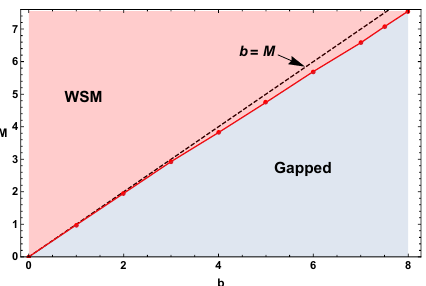
Figure 6. Phase diagram in ( b; M ) space. We used T = 2 =(cid:25) . Unlike the (cid:12)eld theory, M c =b = 1 holds only approximately. Dashed line is for b = M .